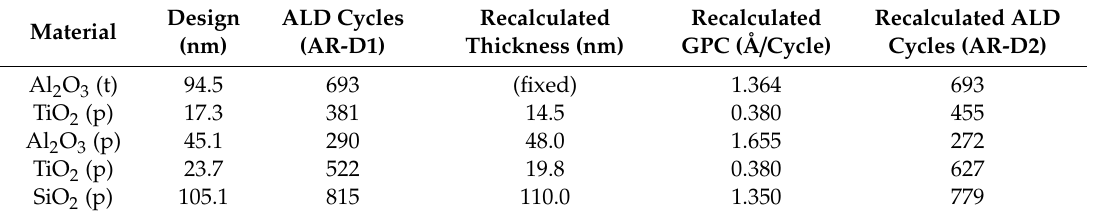
Table 4. Target layer thickness and necessary ALD cycles for AR coating on